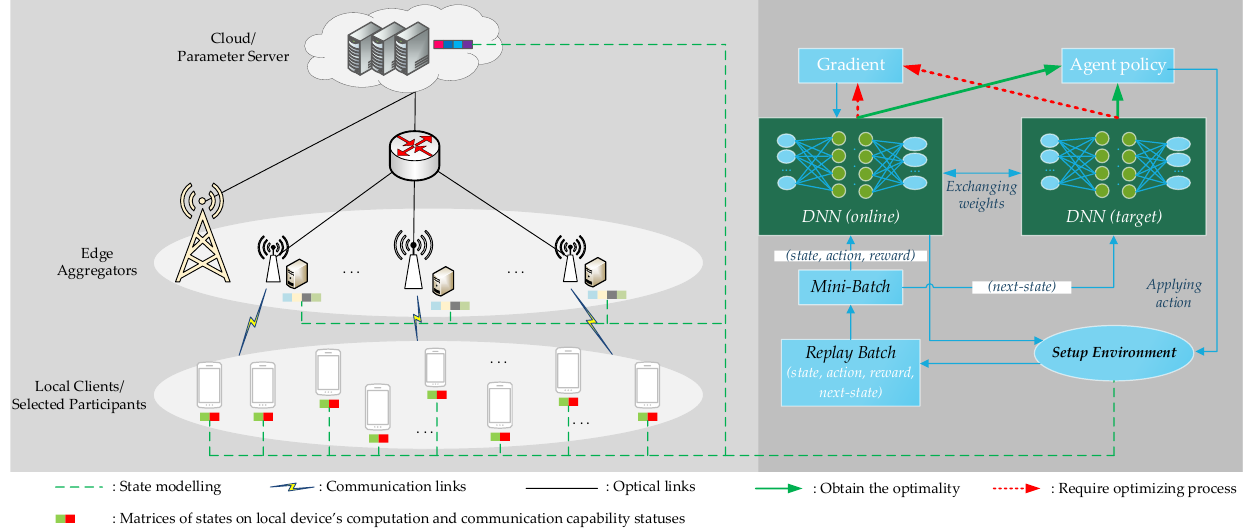
Figure 5. Key interaction and components between DRL agent and FL environment.